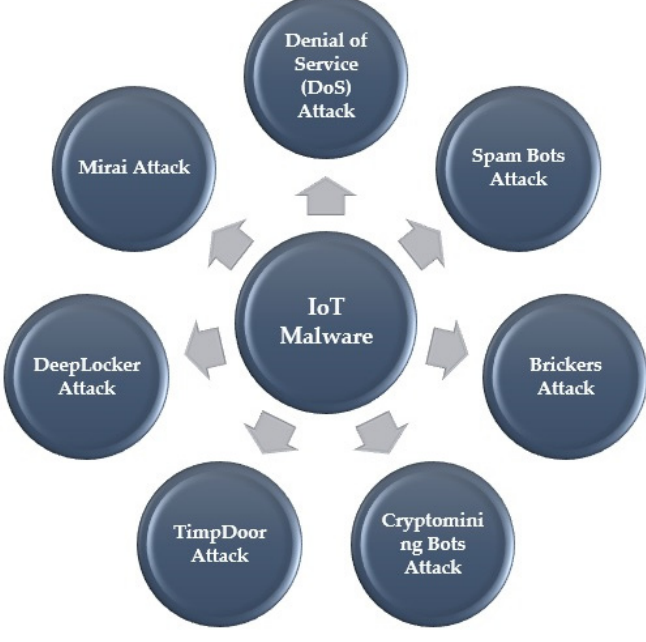
Figure 4. IoT Malware.